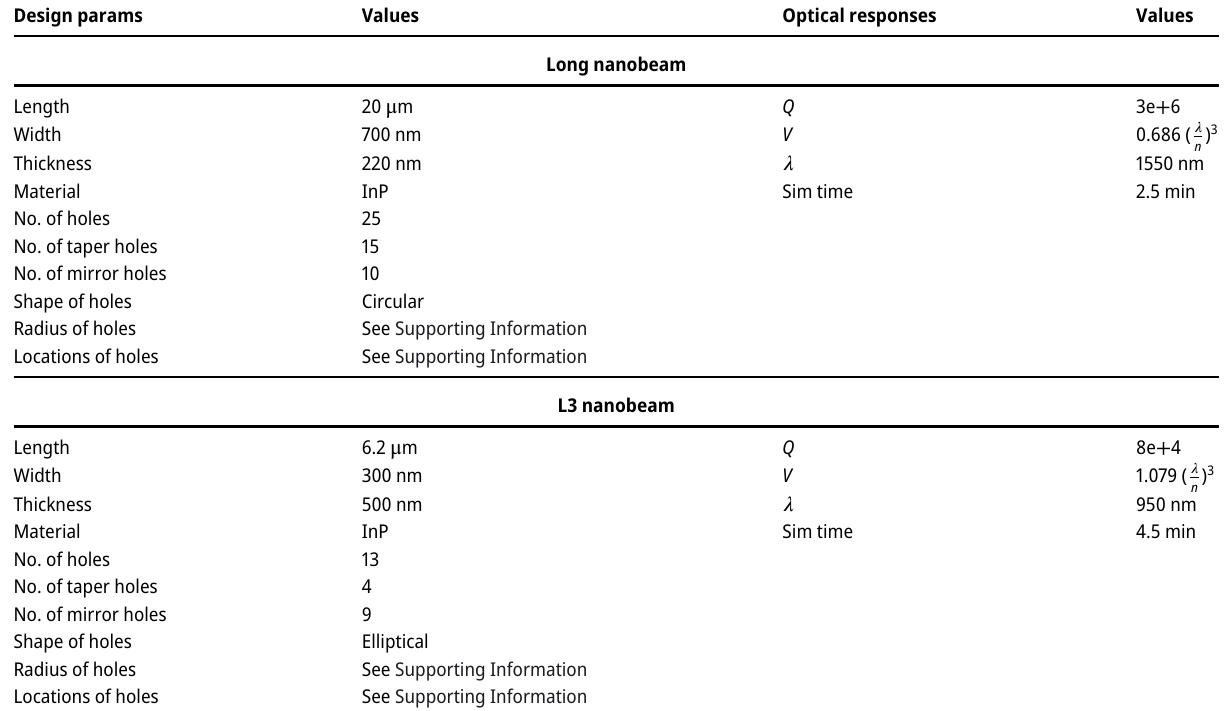
Table 1: Initial design parameters and optical responses of the long nanobeam (top) and L3 nanobeam (bottom), respectively. Initial design parameters are determined according to wafer dimensions, fabrication limitations, and specific application needs. Optical responses are calculated by 3D FDTD simulations using the initial design parameters. “Sim time” denotes how much time it takes to simulate the nanobeam once. Since the L3 nanobeam has elliptical holes, its radius is in fact semi-minor (major)